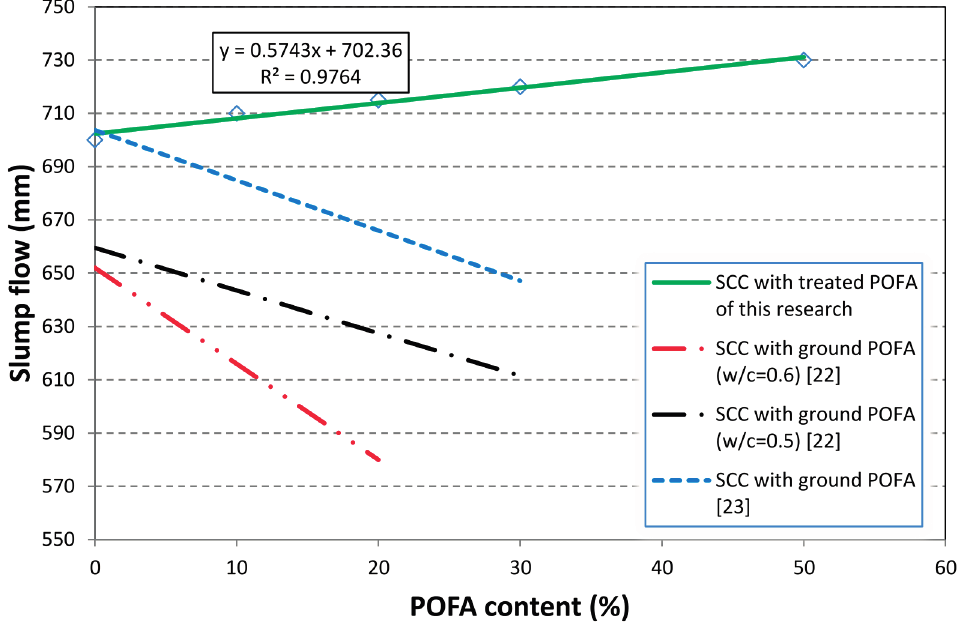
Figure 3. Slump flow for SCC with ground POFA and treated